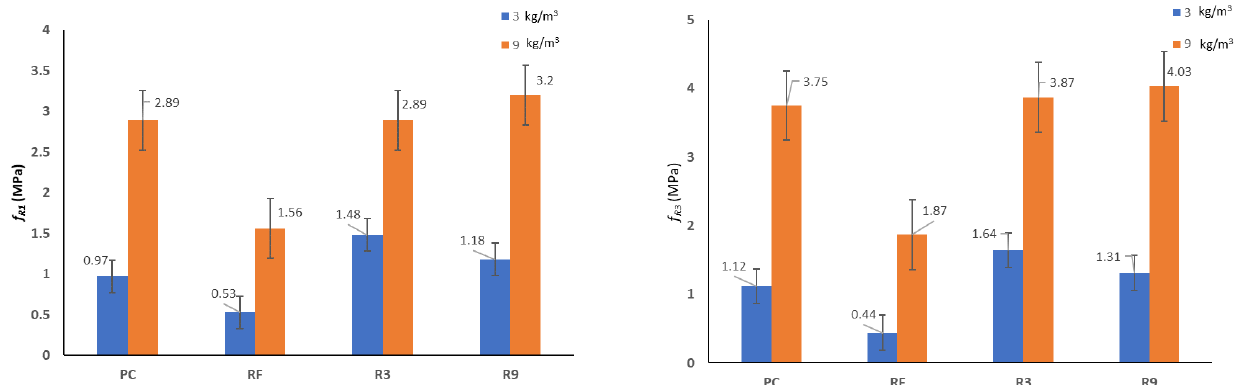
Figure 11. The result of flexural tensile strength: f R1 ( left ); f R3 ( right